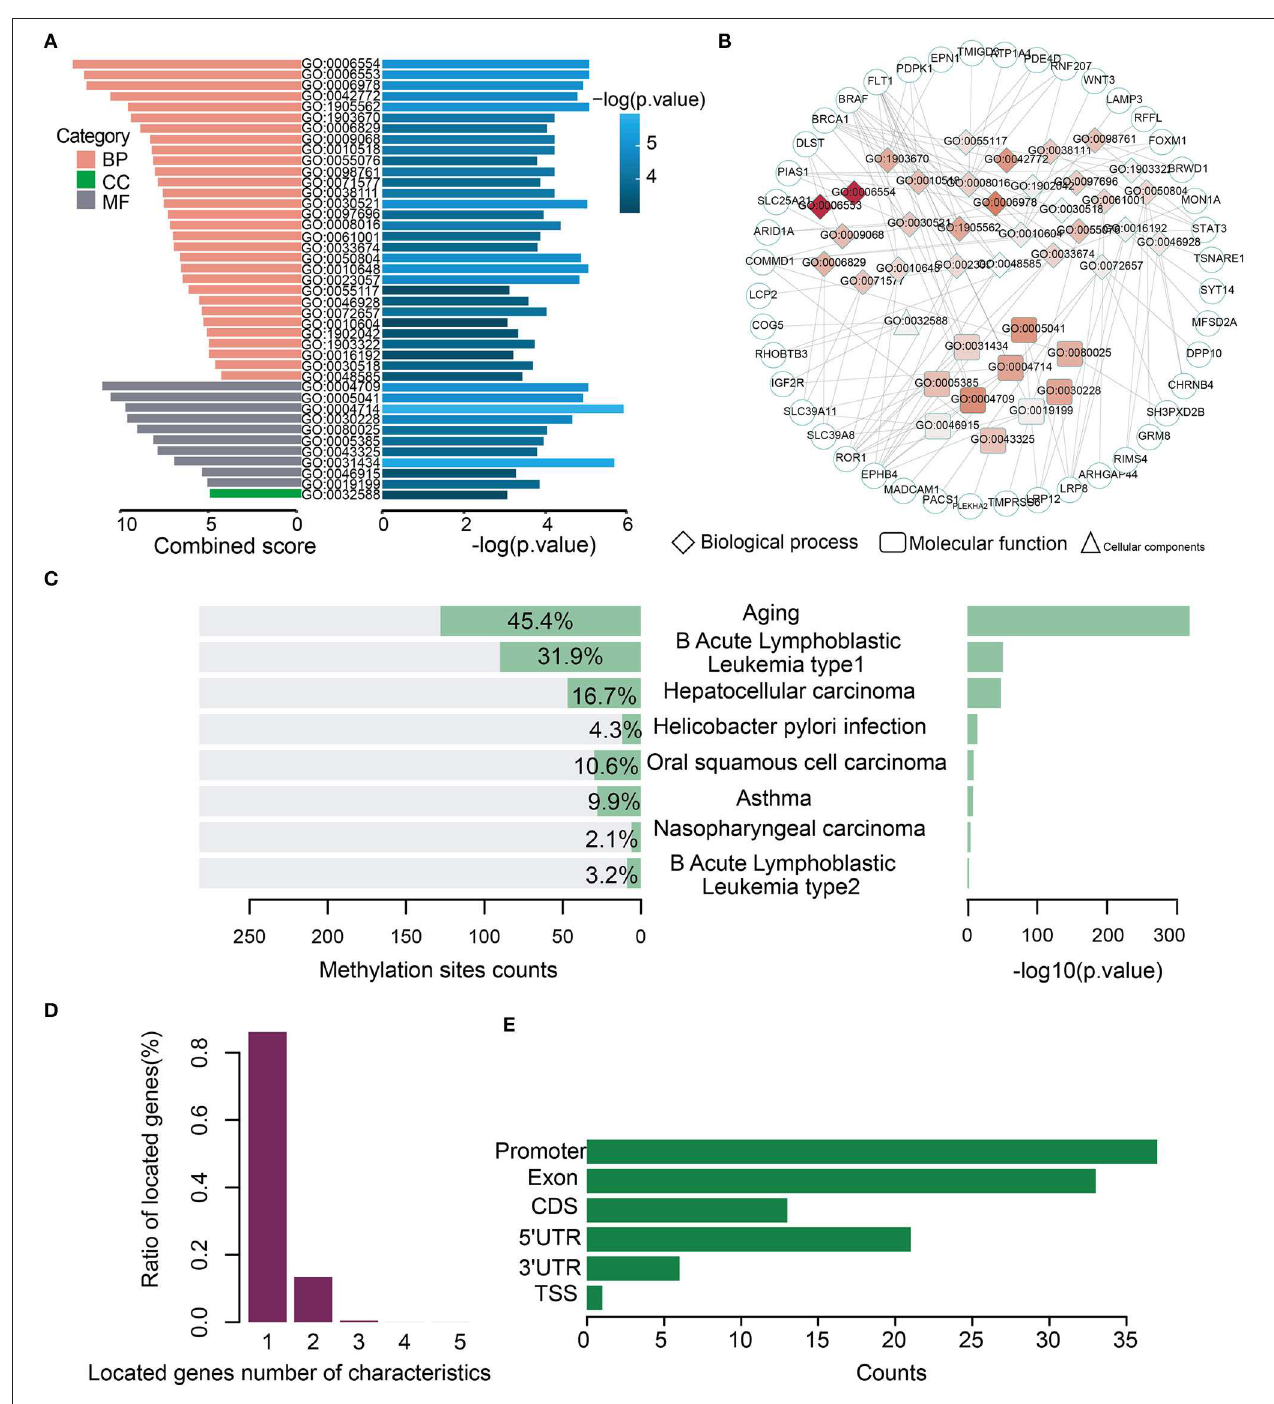
FIGURE 3 | Biological processes and phenotypic traits of age-related methylation sites for CancerClock. (A) The barplot shows the combined score and –log ( p -values) for enrichment GO terms of 282 extracted methylation sites. Pink, green, and gray colors represent biological process (BP), molecular function (MF), and cellular component (CC), respectively. (B) Network shows the interactions between GO terms and genes. The color of node in network indicates enrichment strength, and the three different shapes represent different biological types of GO terms. The circle represents the genes. (C) The bar chart shows the enrichment counts and significance P -values of each trait from EWAS atlas analysis. (D) The corresponding relationship between methylation site and the genes in which it is located. The relationship is usually one-to-one or one-to-many. (E) The distribution of 282 features of CancerClock model in genome position.